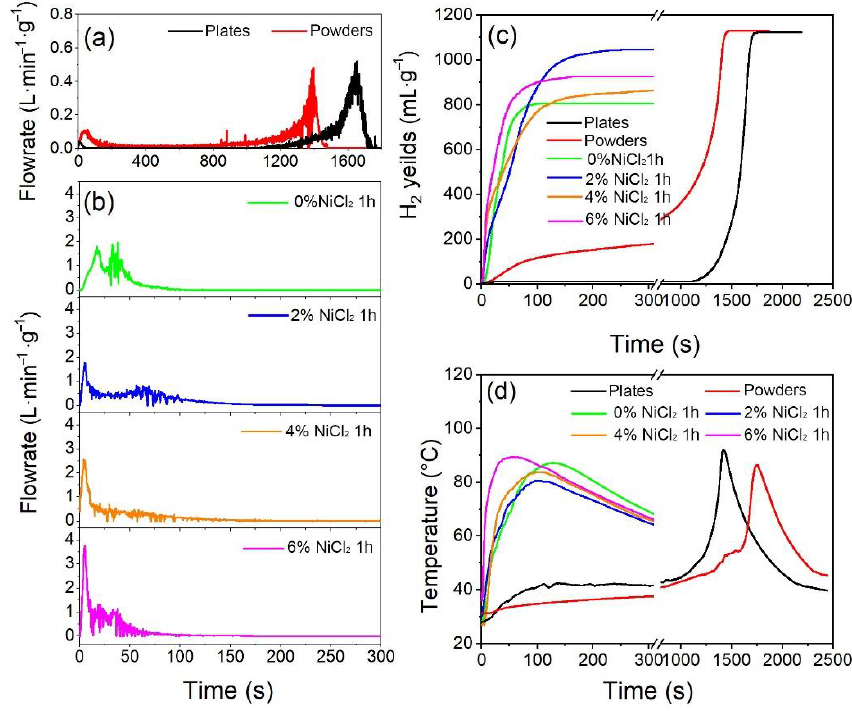
Figure 5. The hydrogen generation rate and temperature of Al-LMP-NiCl 2 samples with water: ( a ) hydrogen generation flow rate of plates and powders, ( b ) hydrogen generation flow rate of ball-milled samples 1–4, ( c ) hydrogen generation yields, and ( d ) temperature change during Al/H 2 O reaction.